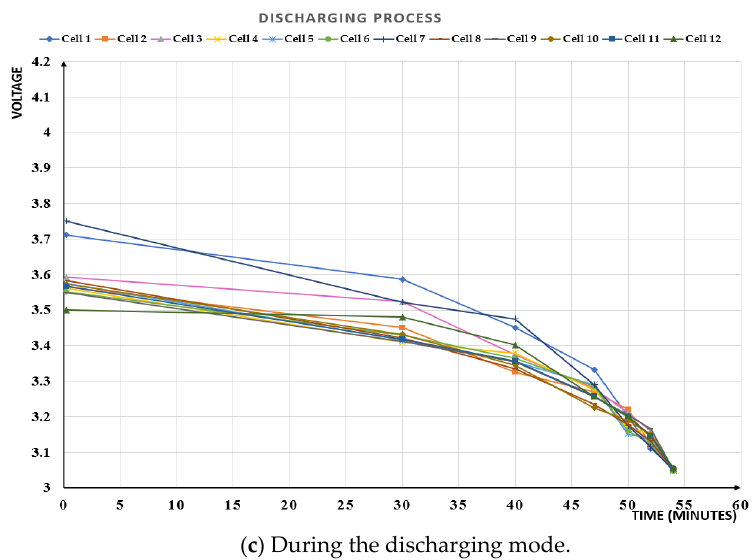
Figure 10. Cell balancing operation of the proposed circuit with twelve Li-ion battery cells.